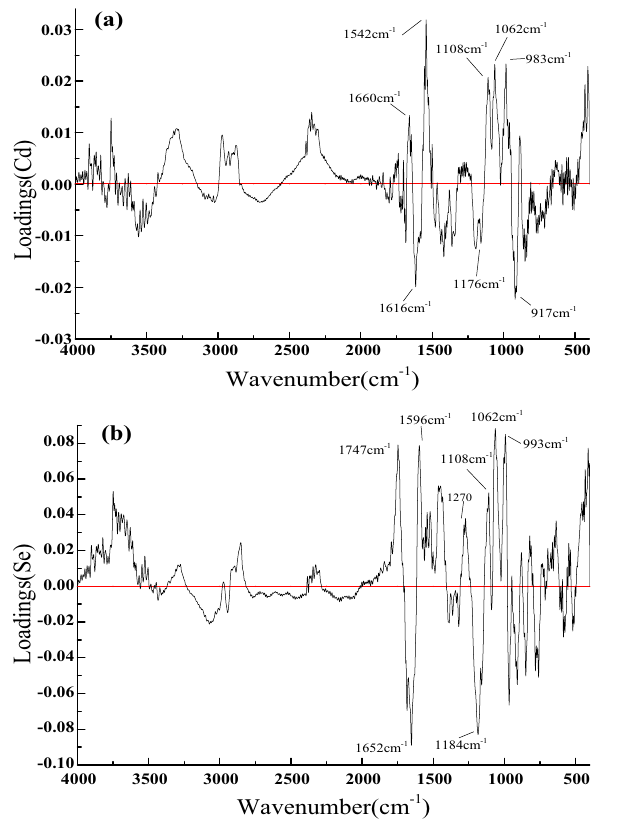
Figure 5. Loadings plot PLSR prediction model for Cd ( a ) and Se ( b